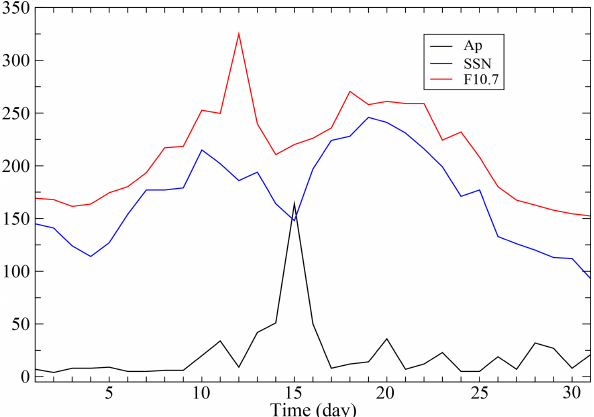
Figure 8. Daily values of Ap, international SSN and F10.7 for July 2000.